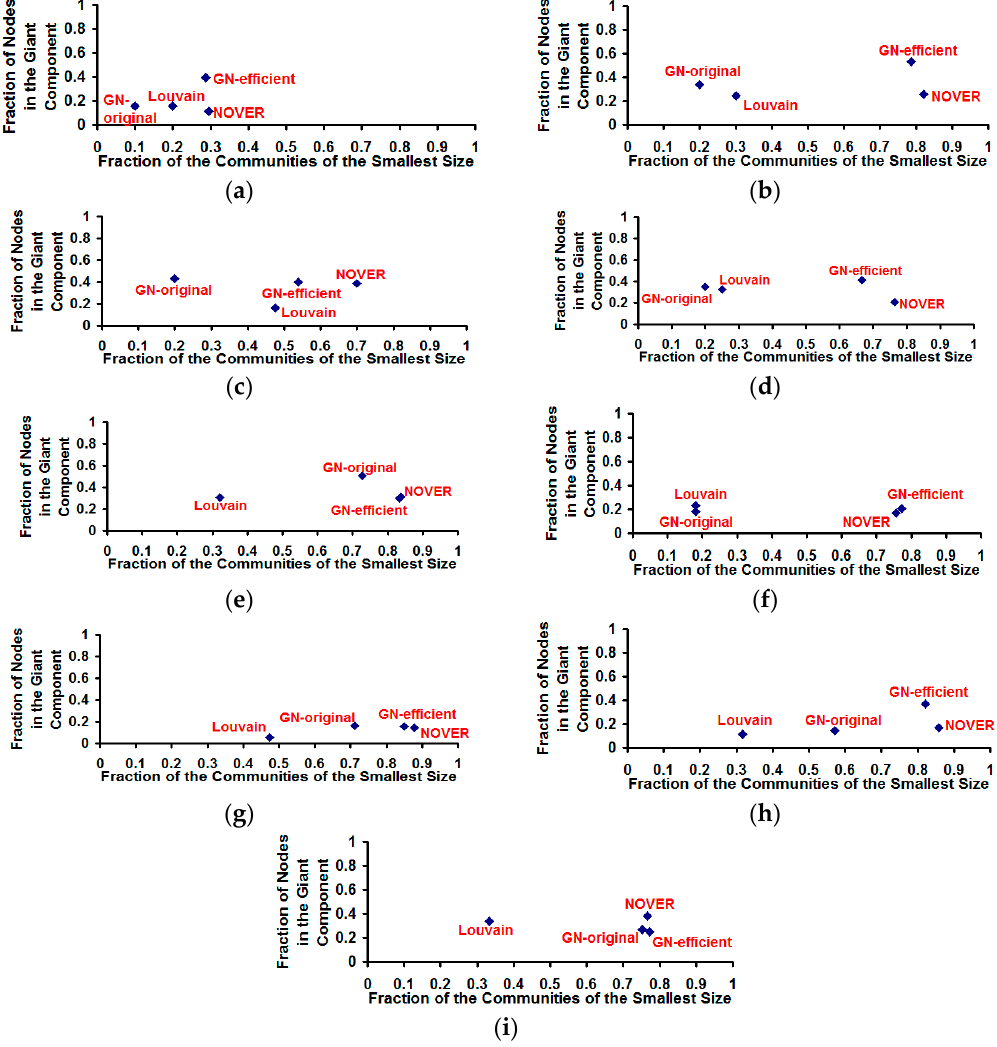
Figure 12. Fraction of nodes in the giant component vs. fraction of the communities of the smallest size for the community detection algorithms on real-world Network graphs. ( a ) US Football Network (FN); ( b ) Dolphin Network (DN); ( c ) US Politics Book Network (PN); ( d ) Karate Network (KN); ( e ) C. Elegans Network (NN); ( f ) Les Miserables Network (LN); ( g ) Citation GD Network (CN); ( h ) Erdos971 Collaboration Network (EN); ( i ) US Airports Network (AN).